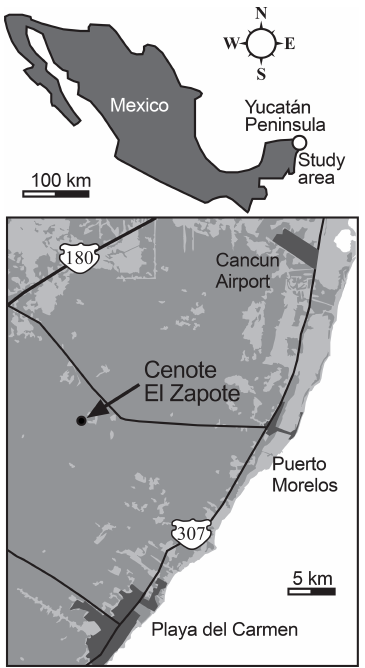
Figure 1. Location of the studied El Zapote cenote with respect to Mexico and the Yucatán